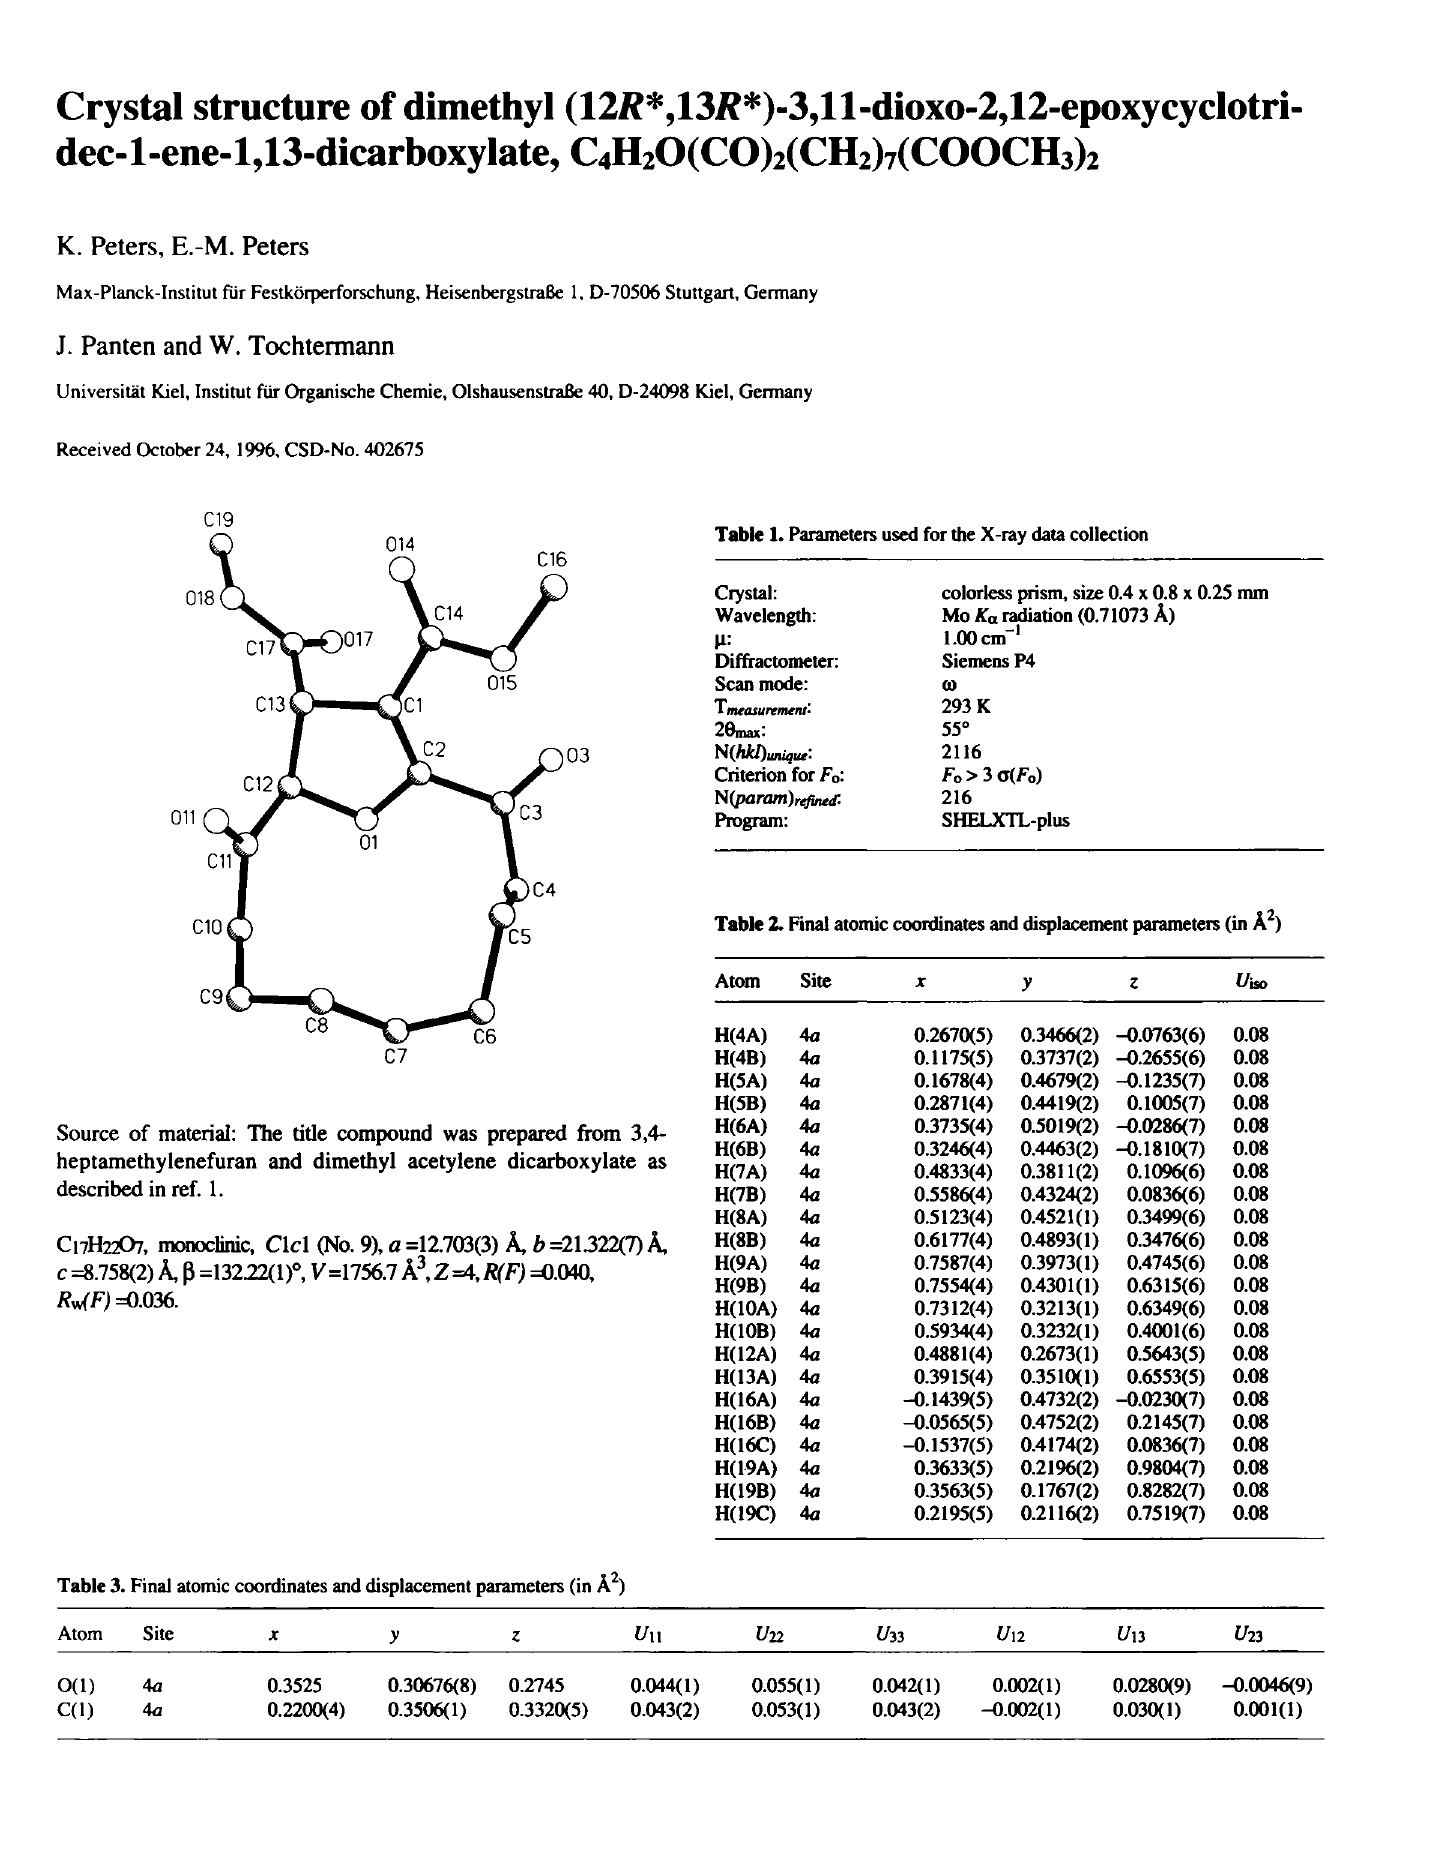
Table 1. Parameters used for the X-ray data collection Crystal: